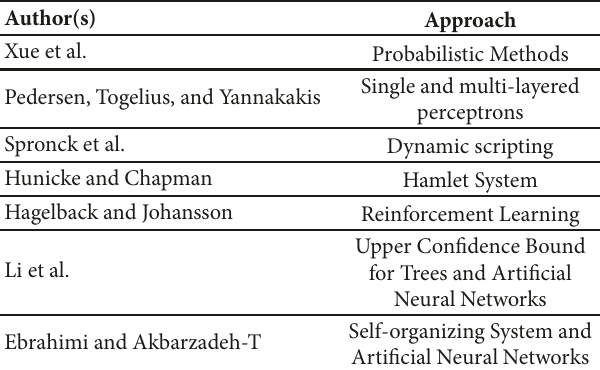
Figure 2: DDA studies over the past decade. Table 2: List of DDA